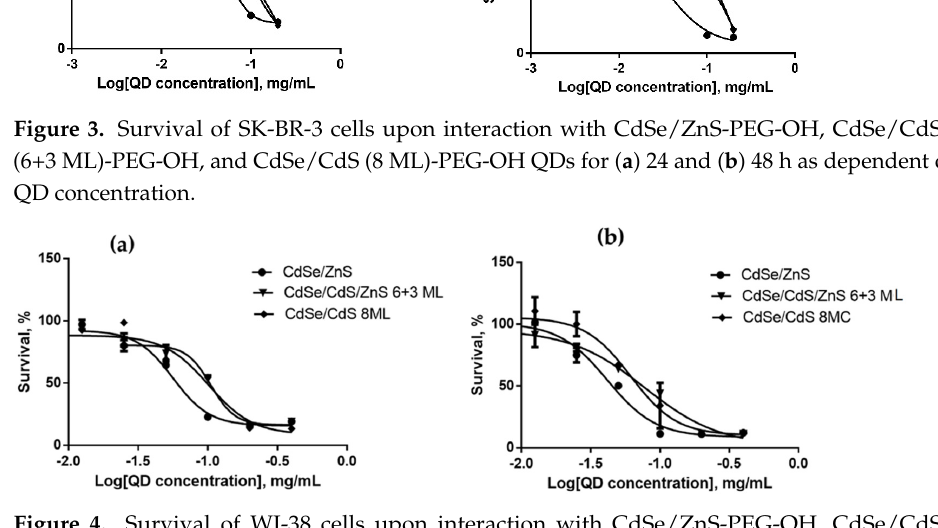
Figure 5. Survival of SK-BR-3 cells upon interaction with CdSe/ZnS-PEG-OH, CdSe/ZnS-PEG- COOH, and CdSe/ZnS-PEG-NH 2 QDs for ( a ) 24 and ( b ) 48 h as dependent on the QD concentration.